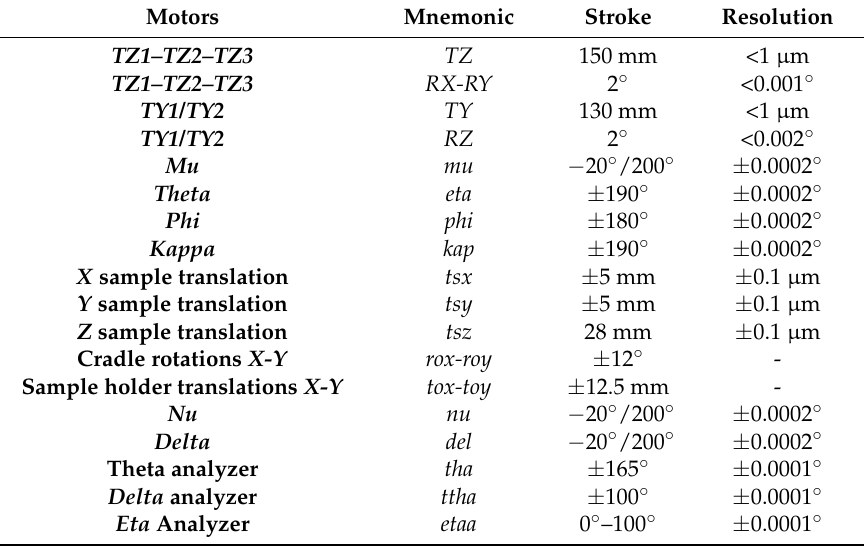
Table 1. List of the D2AM Diffractometer Motors and Their Respective Mnemonics, Strokes, and